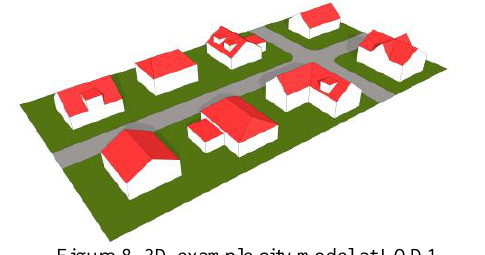
Figure 8. 3D example city model at LOD1